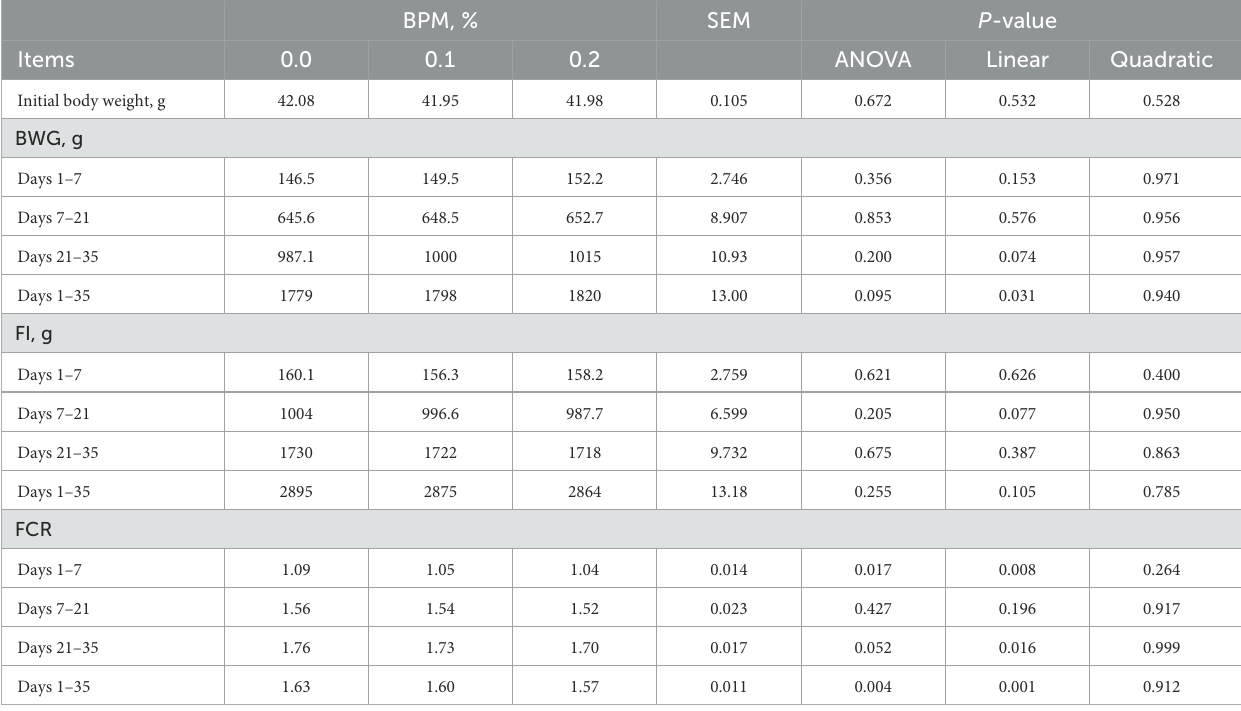
TABLE 3 Effect of dietary supplementation of Bacillus subtilis and Pichia farinose mixture (BPM) on growth performance of broiler chicks ∗